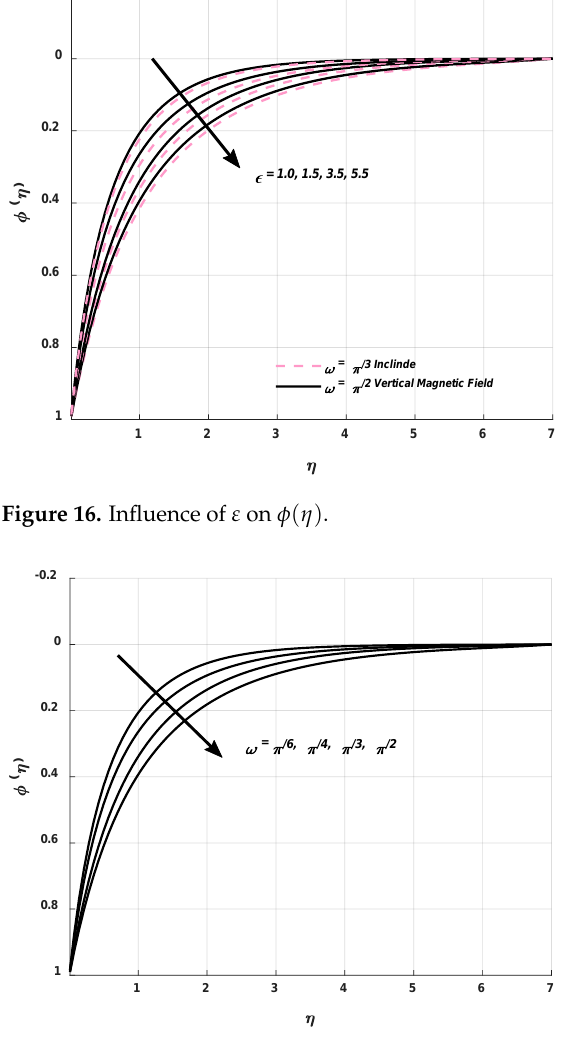
. Figure 17. Influence of w on φ ( η ) . . 𝜙𝜙(𝛾𝛾) 𝜙𝜙(𝛾𝛾) 𝜙𝜙(𝛾𝛾)